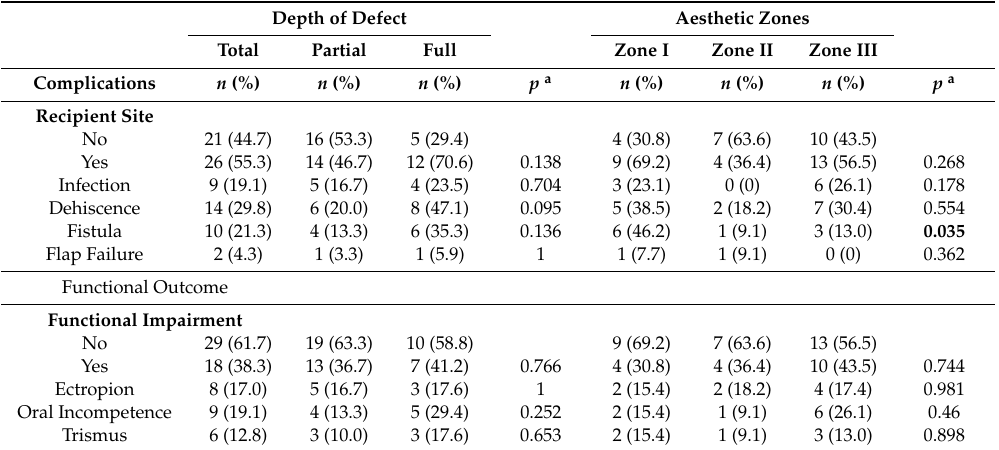
Table 3. Complications and functional outcome according to depth of defect and aesthetic zone. Depth of Defect Aesthetic Zones Total Partial Full Zone I Zone